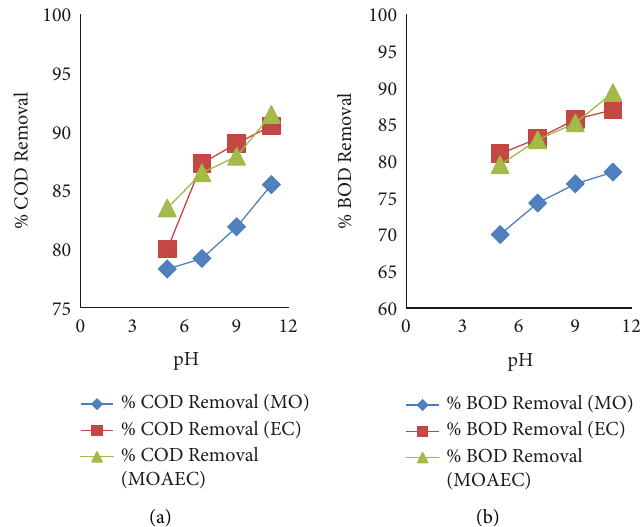
Figure 3: Effects of pH on COD (a) and BOD (b) removal efficiency using Moringa Oleifera (MO), electrocoagulation (EC), and Moringa Oleifera -assisted EC (MOAEC).